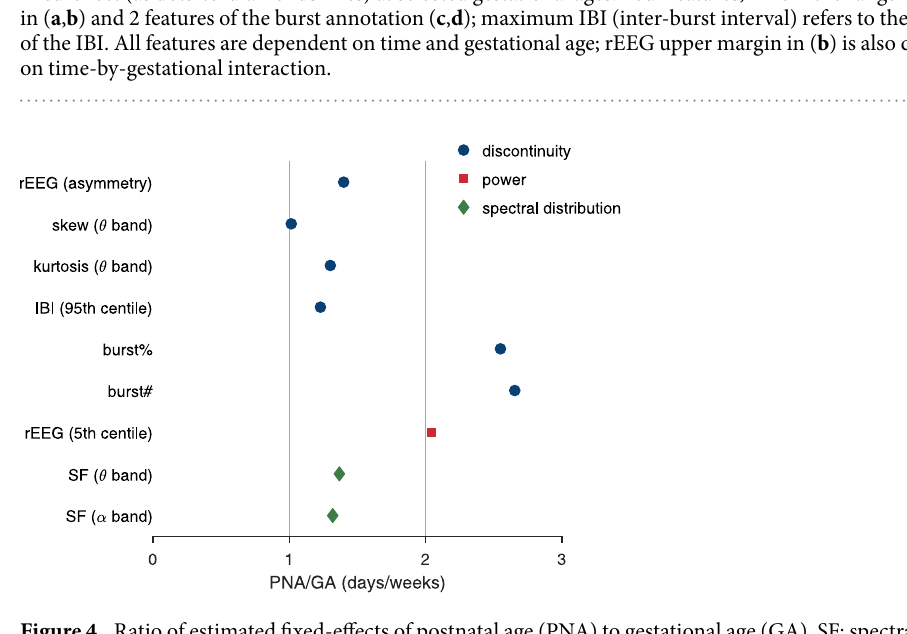
Figure 4. Ratio of estimated fixed-effects of postnatal age (PNA) to gestational age (GA). SF: spectral flatness; rEEG: range EEG; IBI: inter-burst interval; burst%: burst ratio; burst#: number of bursts. Frequency bands defined as 3–8 Hz for θ and 8–15 Hz for α